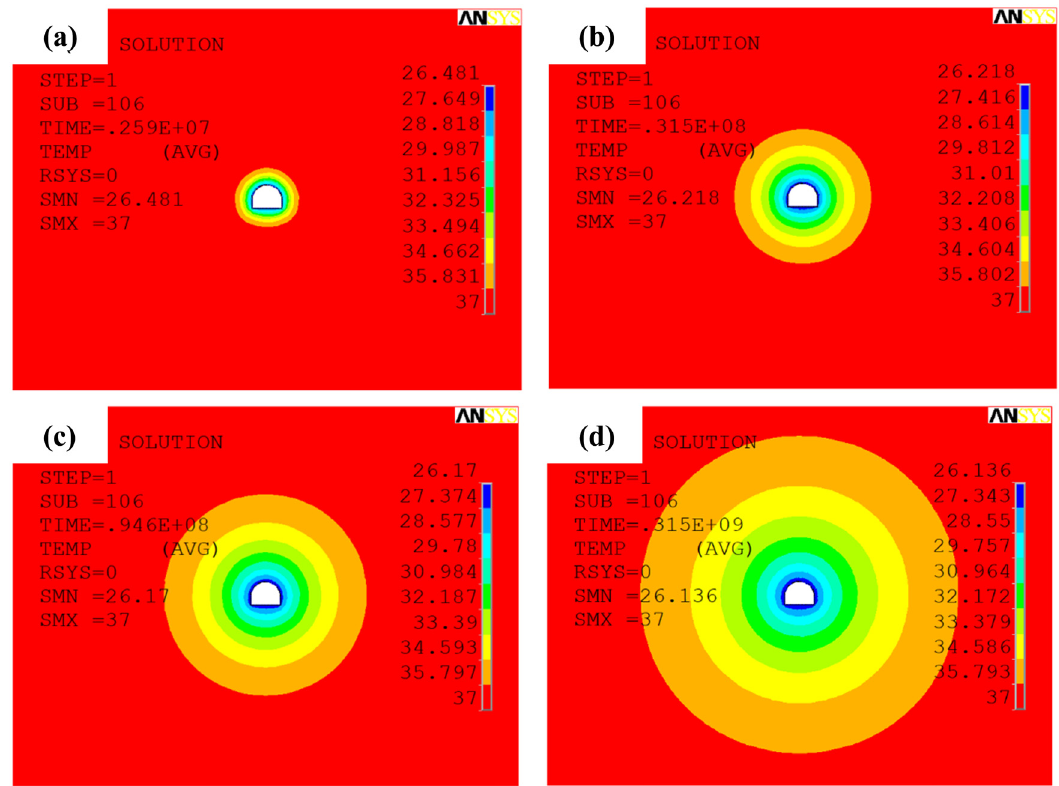
Figure 5: Temperature field of roadway surrounding rock under normal working condition: ( a ) 30 days; ( b ) 365 days; ( c ) 1,095 days; ( d ) 3,650